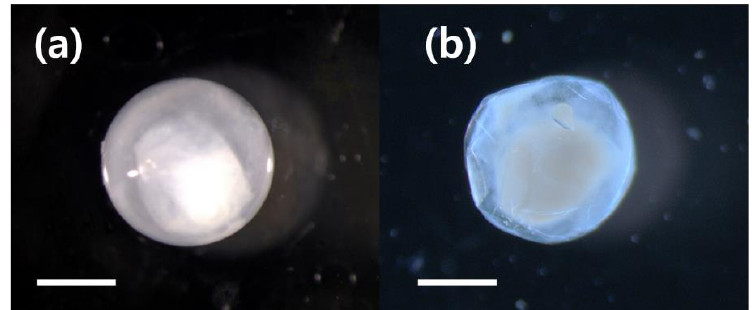
Figure 3. Photograph of an eggs of M. cinereus collected from waters adjacent to Jeju Island. ( a ) egg diameter = 2.1 mm, ( b ) egg diameter = 2.0 mm. Scale bar = 1.0 mm. Developmental counts and measurement of M. cinereus preleptocephali and lepto- cephali are presented in Table 3. The TL of hatched M. cinereus preleptocephali and lep- tocephali was 11.5–13.5 and 20.9–34.4 mm, respectively, and their morphological features were as follows: total myomeres 145–153; preanal myomeres, 93–98; transparent and deeply compressed body; relatively large head; highly acute anterior end of snout; well-developed eyes; fang-like teeth on both jaws; two nostrils present in front of eyes; liver tissue located in anterior body; anus located in posterior body; branch-shaped melanophores present along the lateral surfaces of the head to behind the anus and extending to the caudal terminus; and branch-shaped melanophores present in the intestine (Figure 4). The upper jaw of 11.5 mm TL M. cinereus preleptocephalus was more protruded than the lower jaw (Figure 4a), and the length of both upper and lower jaws were identical in lep- tocephalus of 23.5 mm TL (Figure 4b). The tail fin of leptocephalus with 31.5 – 34.4 mm TL had begun to develop (Figure 4c). As they grew from 31.5 mm TL and above following hatching, their body depth became smaller and their myomeres became identical to those of an adult fish. Table 3. Comparisons of measurements and counts for Muraenesox cineleus preleptocephali and lep- tocephali. Development